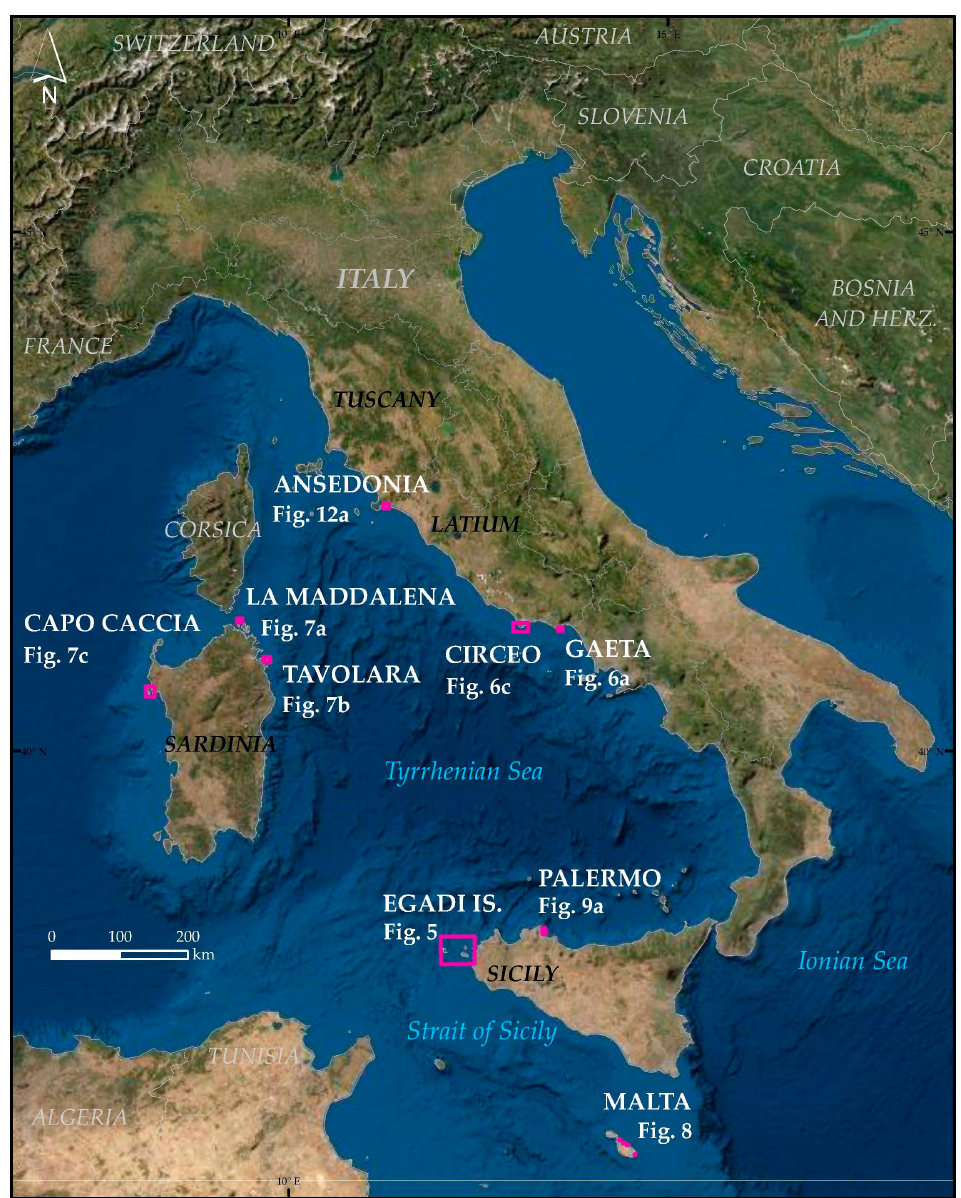
Figure 1. The study areas and the surveyed sites.